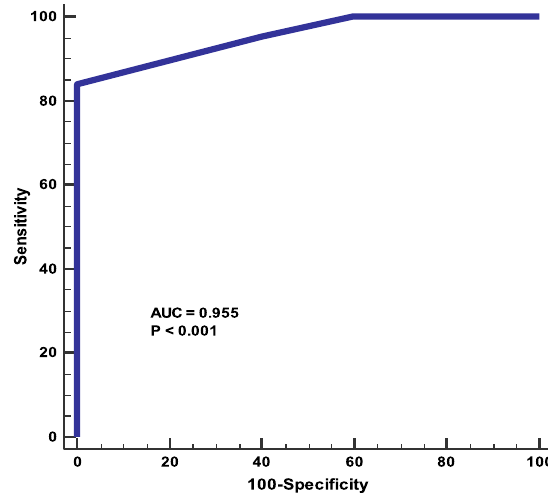
Fig. 3 Accuracy of the apparent diffusion coefficient (ADC) in prediction of active tracts among the studied patients